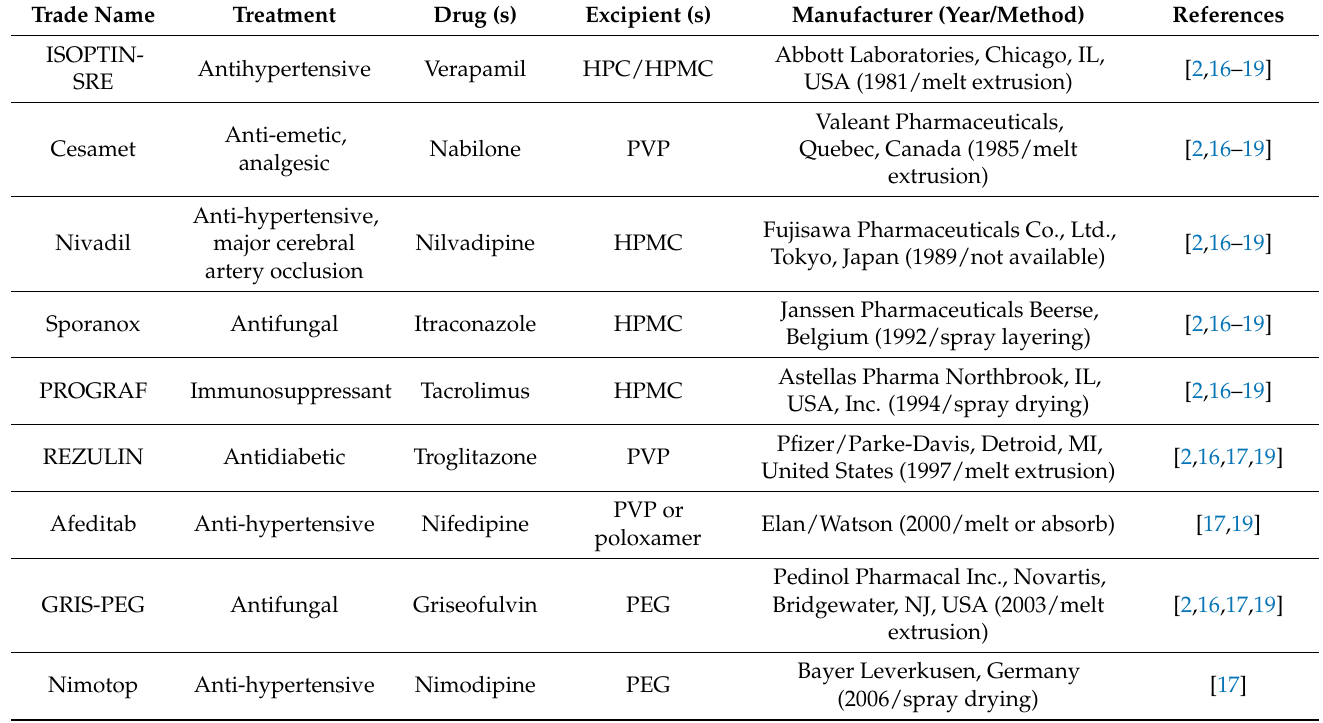
Table 1. Examples of commercial amorphous drug-delivery products by FDA approval